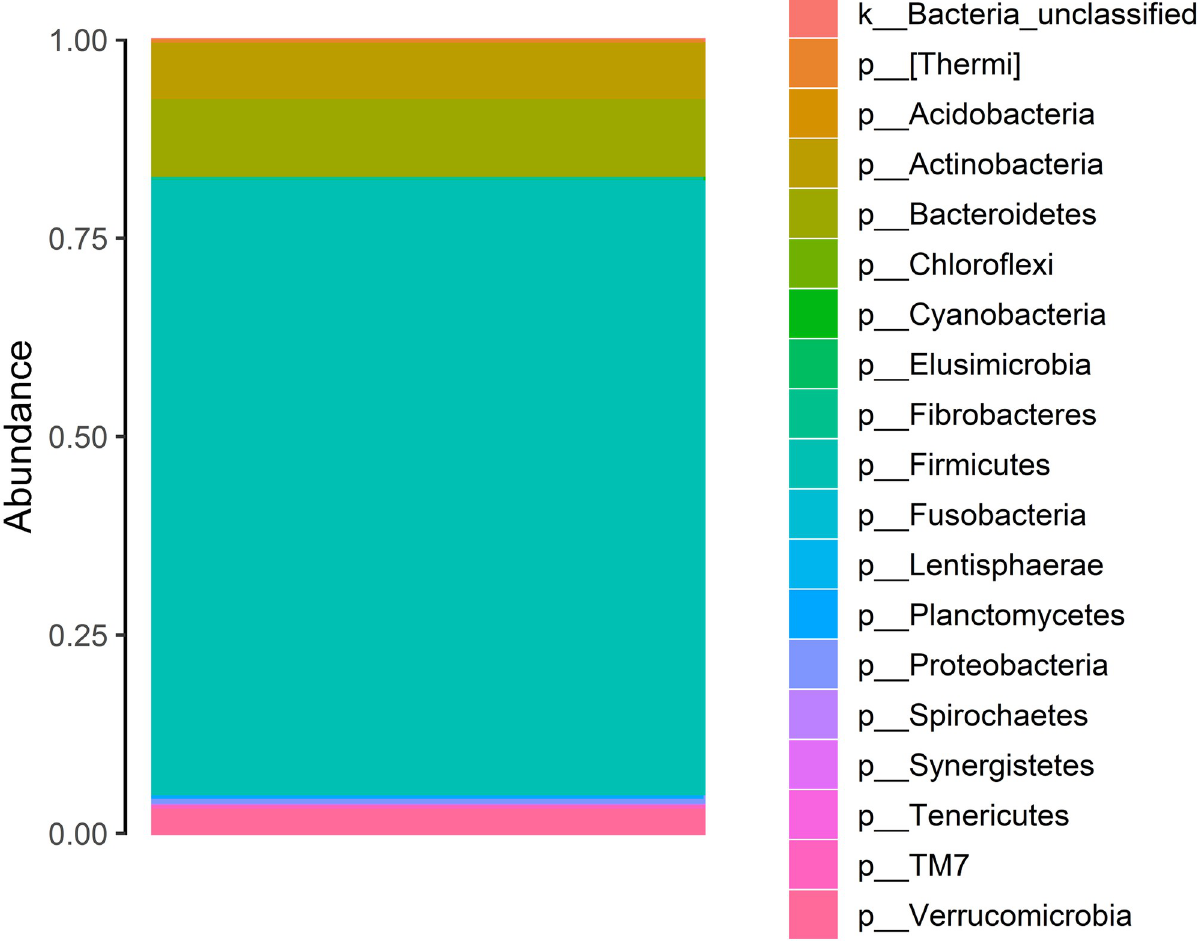
PLOS ONE | https://doi.org/10.1371/journal.pone.0276684 October 26,